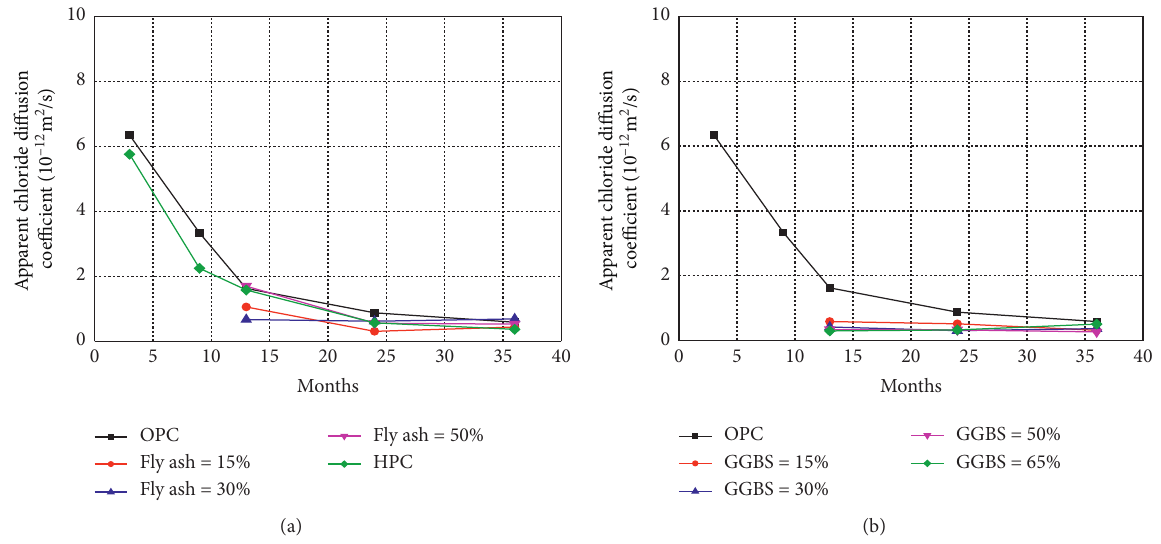
Figure 9: Apparent chloride ion diffusion coefficient of concrete. (a) With fly ash. (b) With